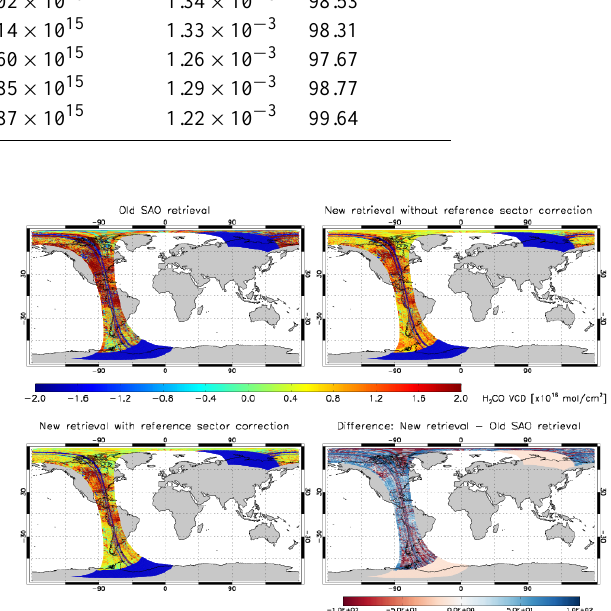
Figure 9. VCD retrieval for Orbit 43214, on 29 August 2012. The panels show the old SAO retrieval (top left), the new retrieval with- out reference sector correction applied to it (top right), the new re- trieval with the reference sector correction applied (bottom left), and the difference between the new retrieval with the reference sector correction applied to it expressed as percent of the old operational retrieval (bottom